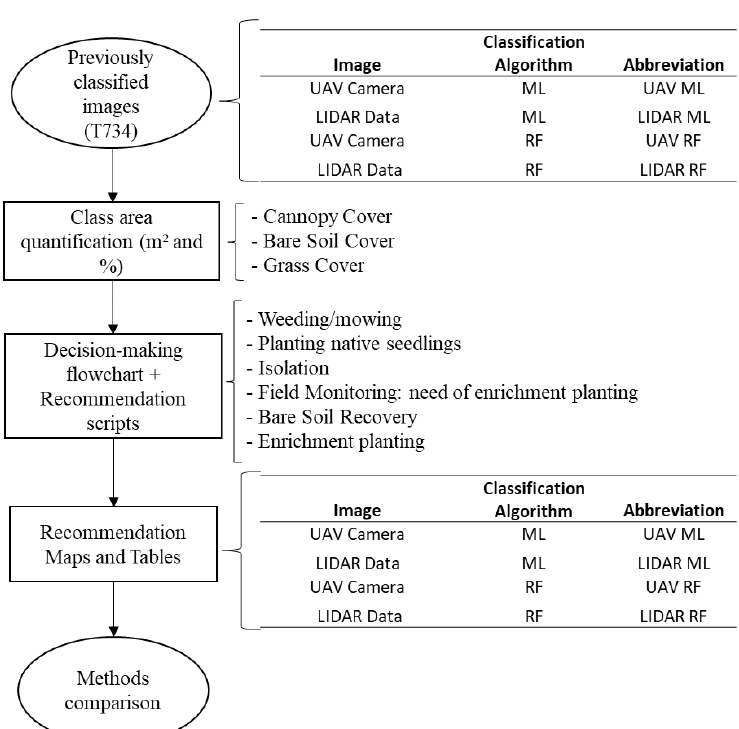
Table 1. Selected land cover indicators for restoration monitoring with UAV and LiDAR, and categorization defined according to reference values for each class.